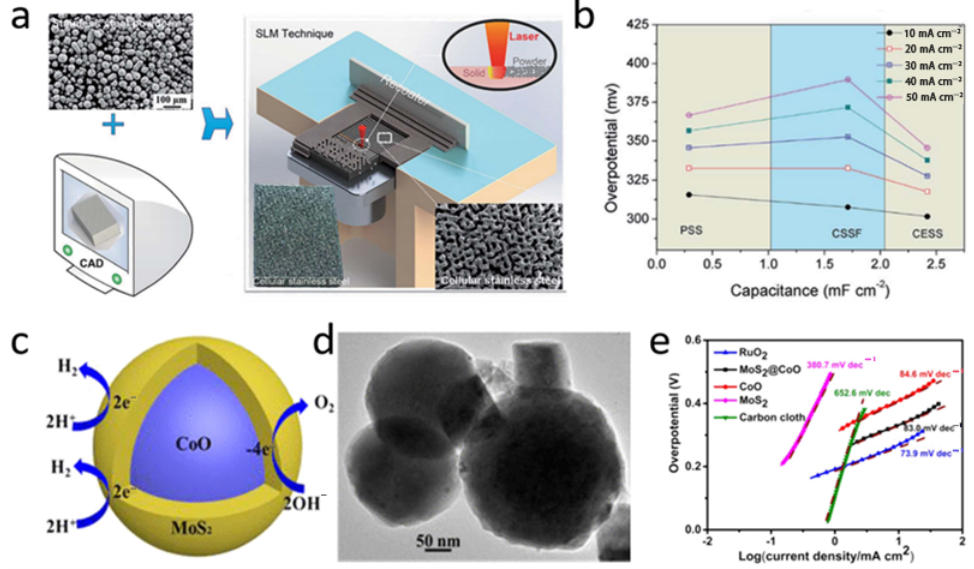
Figure 5. ( a ) Preparation process and ( b ) overpotential of CESS [51]. ( c ) OER mechanism, ( d ) TEM image, and ( e ) Tafel plots of MoS 2 @CoO [52]. Adapted with permission Ref. [51], Copyright 2019, Royal Society of Chemistry. Ref. [52], Copyright 2019, American Chemical Society.